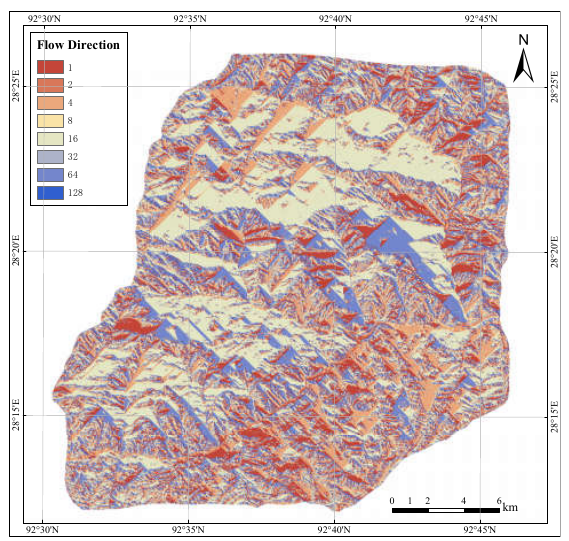
Figure 5. Flow direction of each grid cell.